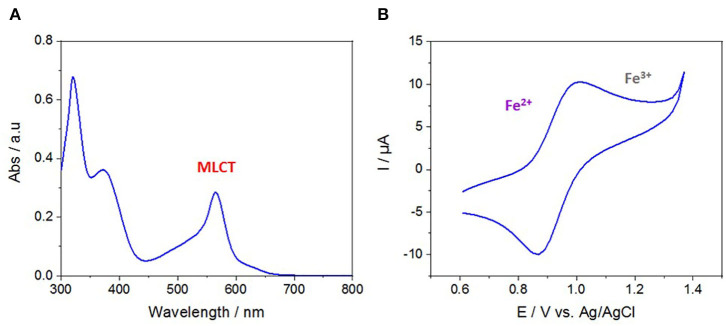
(A) UV-Vis absorption spectrum of a solution containing 0.5 × 10−5 M [Fe(tpy)2(BF4)2] in acetonitrile. (B) Cyclic voltammogram of 0.5 mM [Fe(tpy)2(BF4)2] in 0.1 M TBABF4 in acetonitrile at 50 mV s−1.